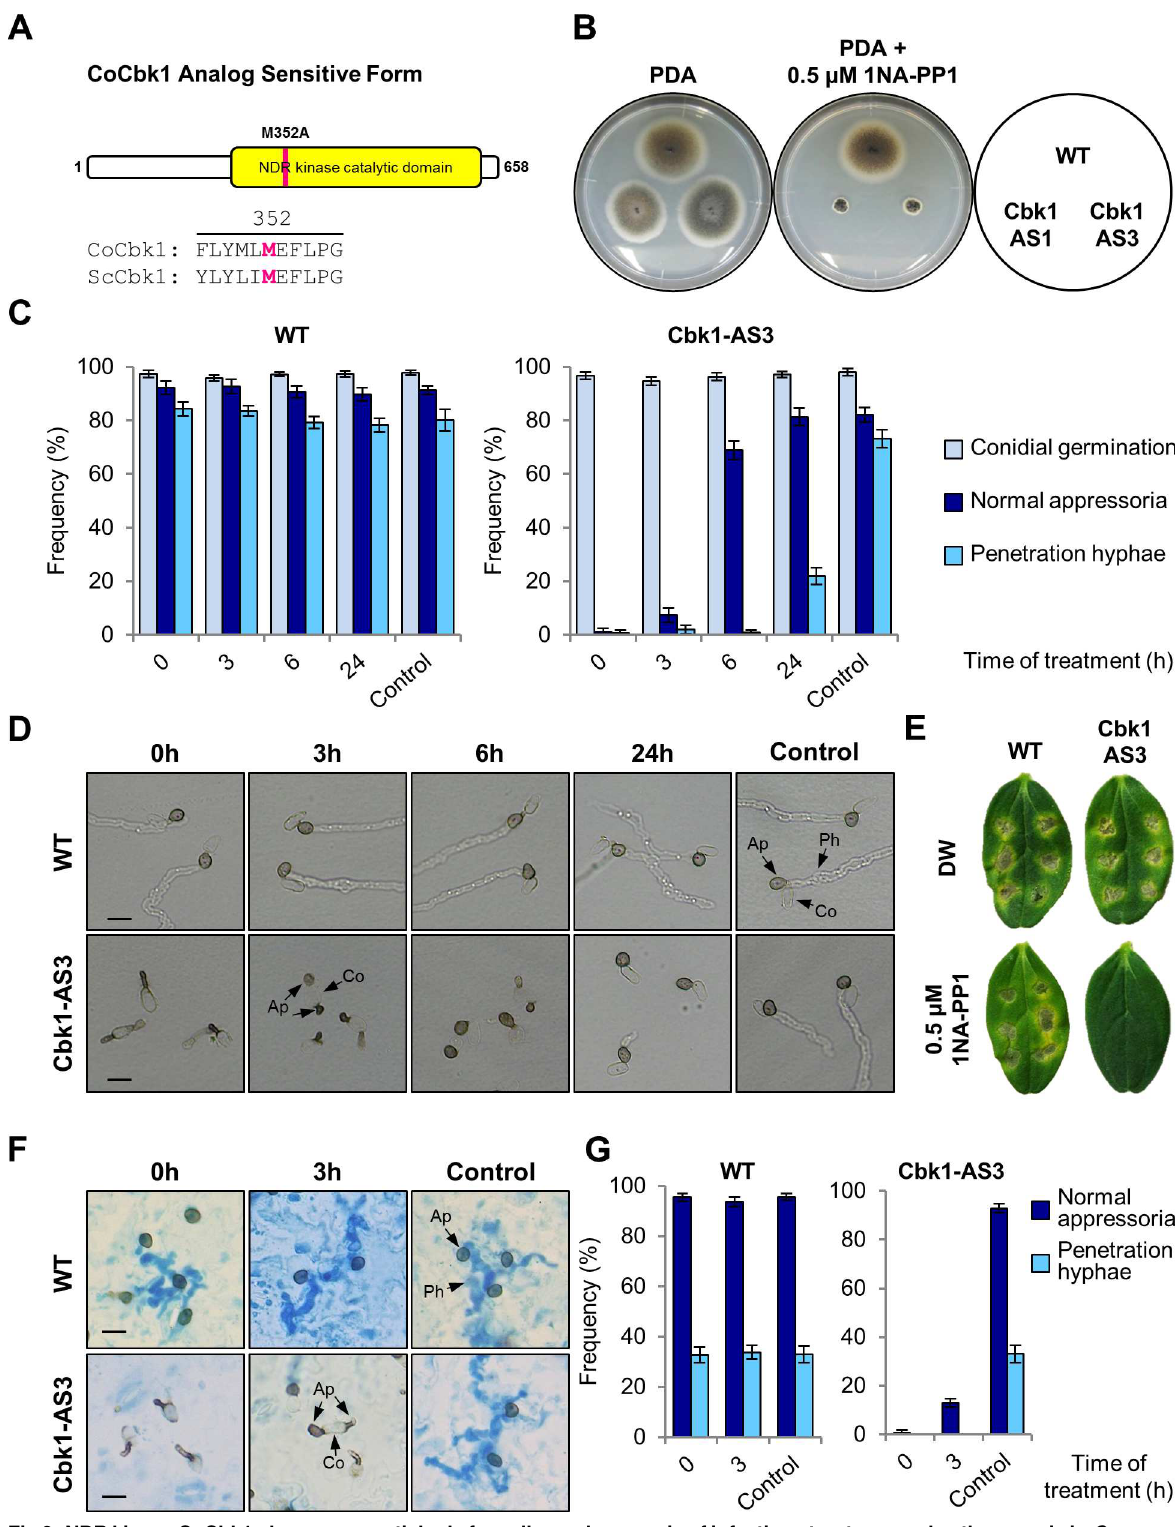
Fig 2. NDR kinase CoCbk1 plays an essential role for cell morphogenesis of infection structuresand pathogenesis in C . orbiculare . (A) Schematic illustration of CoCbk1analog-sensitive (AS) protein and sequencealignment includingthe ATP-binding pocket in C . orbiculare (Co) Cbk1 with corresponding sequencesof S . cerevisiae (Sc) Cbk1. The kinase domainand site of theamino